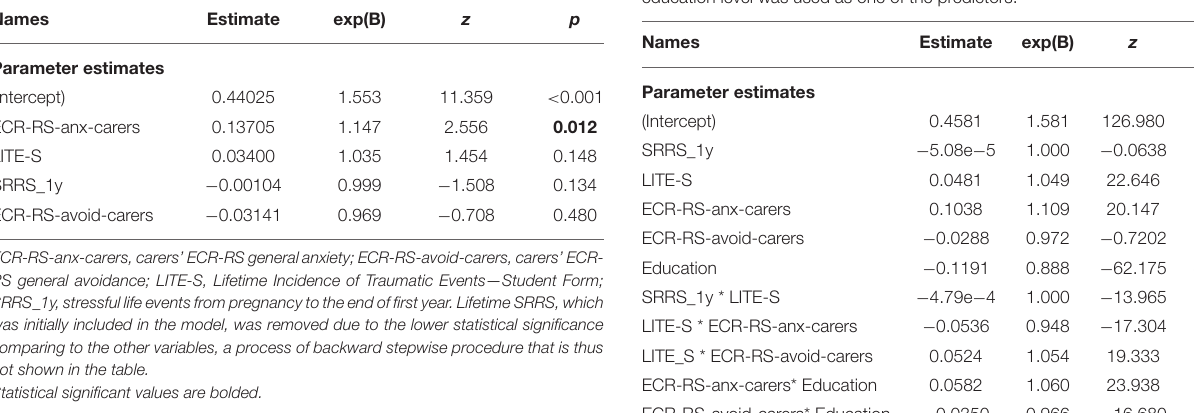
TABLE 3 | Results of the binary multinomial logistic regression model: carer’s attachment-related anxiety/avoidance and stressful life events—mothers’ education level was used as one of the